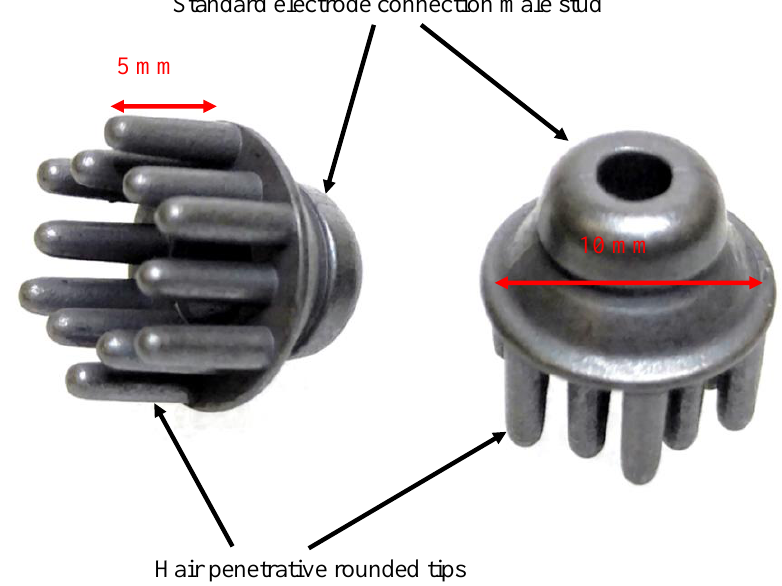
Figure 5. Dry electrodes used for this project.